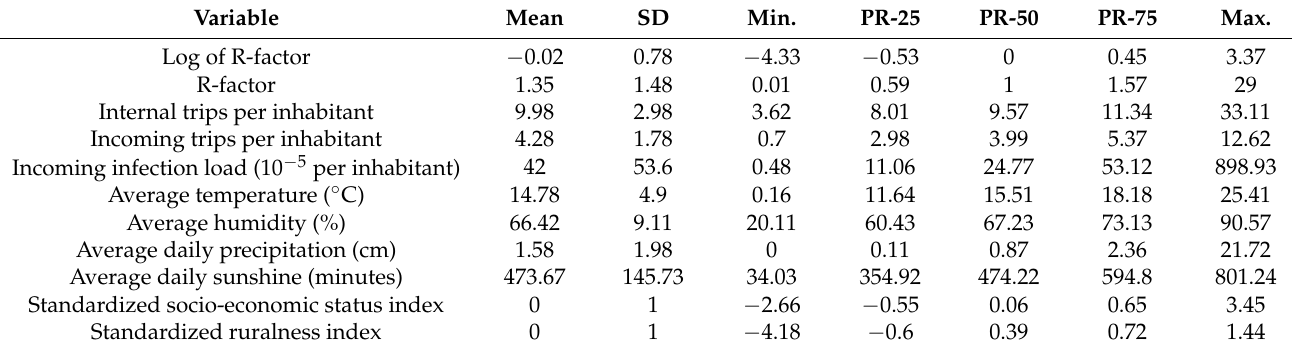
Table 2. Descriptive statistics. All timeseries data relates to weekly values from 9 March through 20 September 2020.